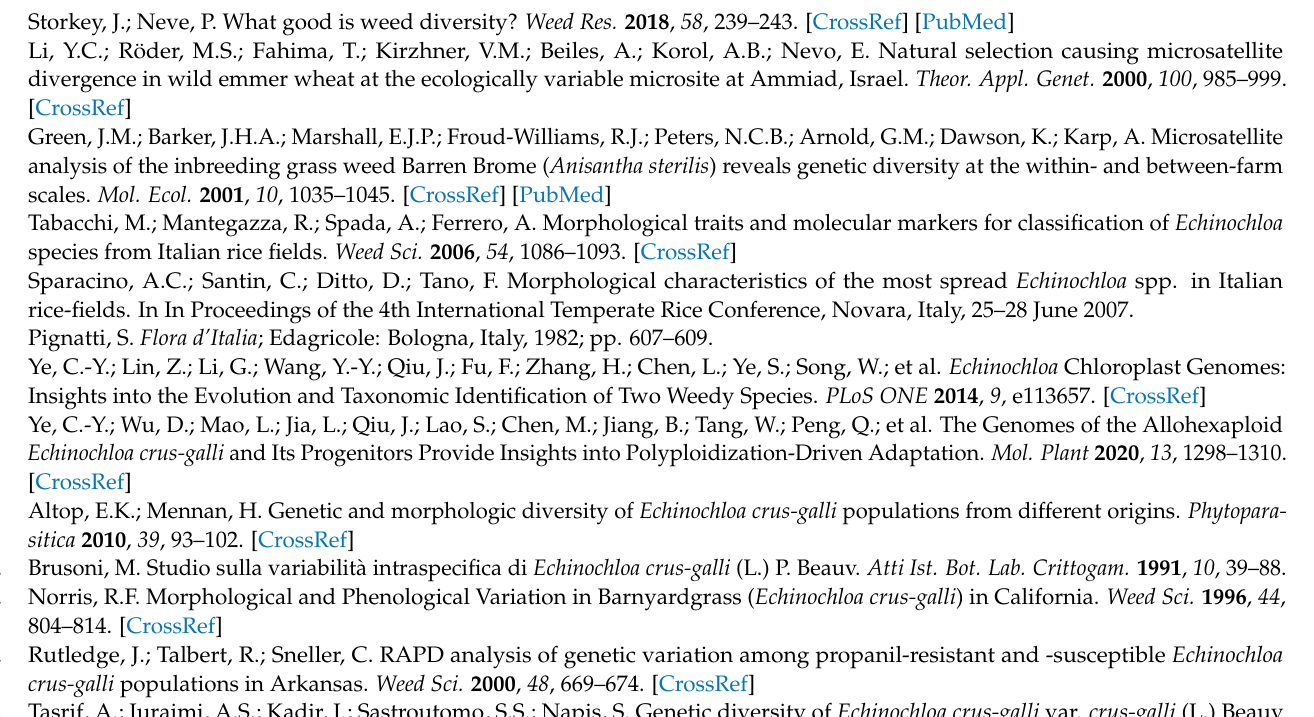
Table S3: Pairwise Fst values between populations, Figure S1: levelplot of pairwise Fst be- tween